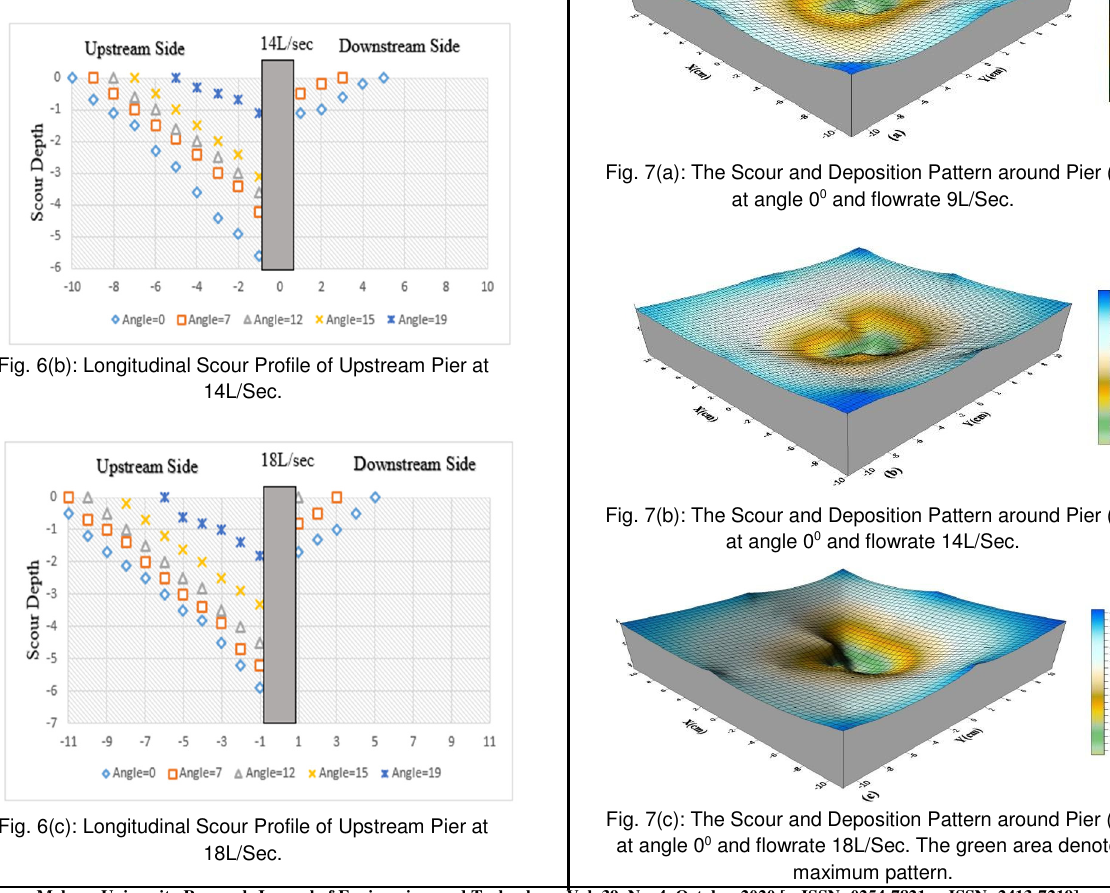
Fig. 6(a): Longitudinal Scour Profile of Upstream Pier at 9L/Sec.